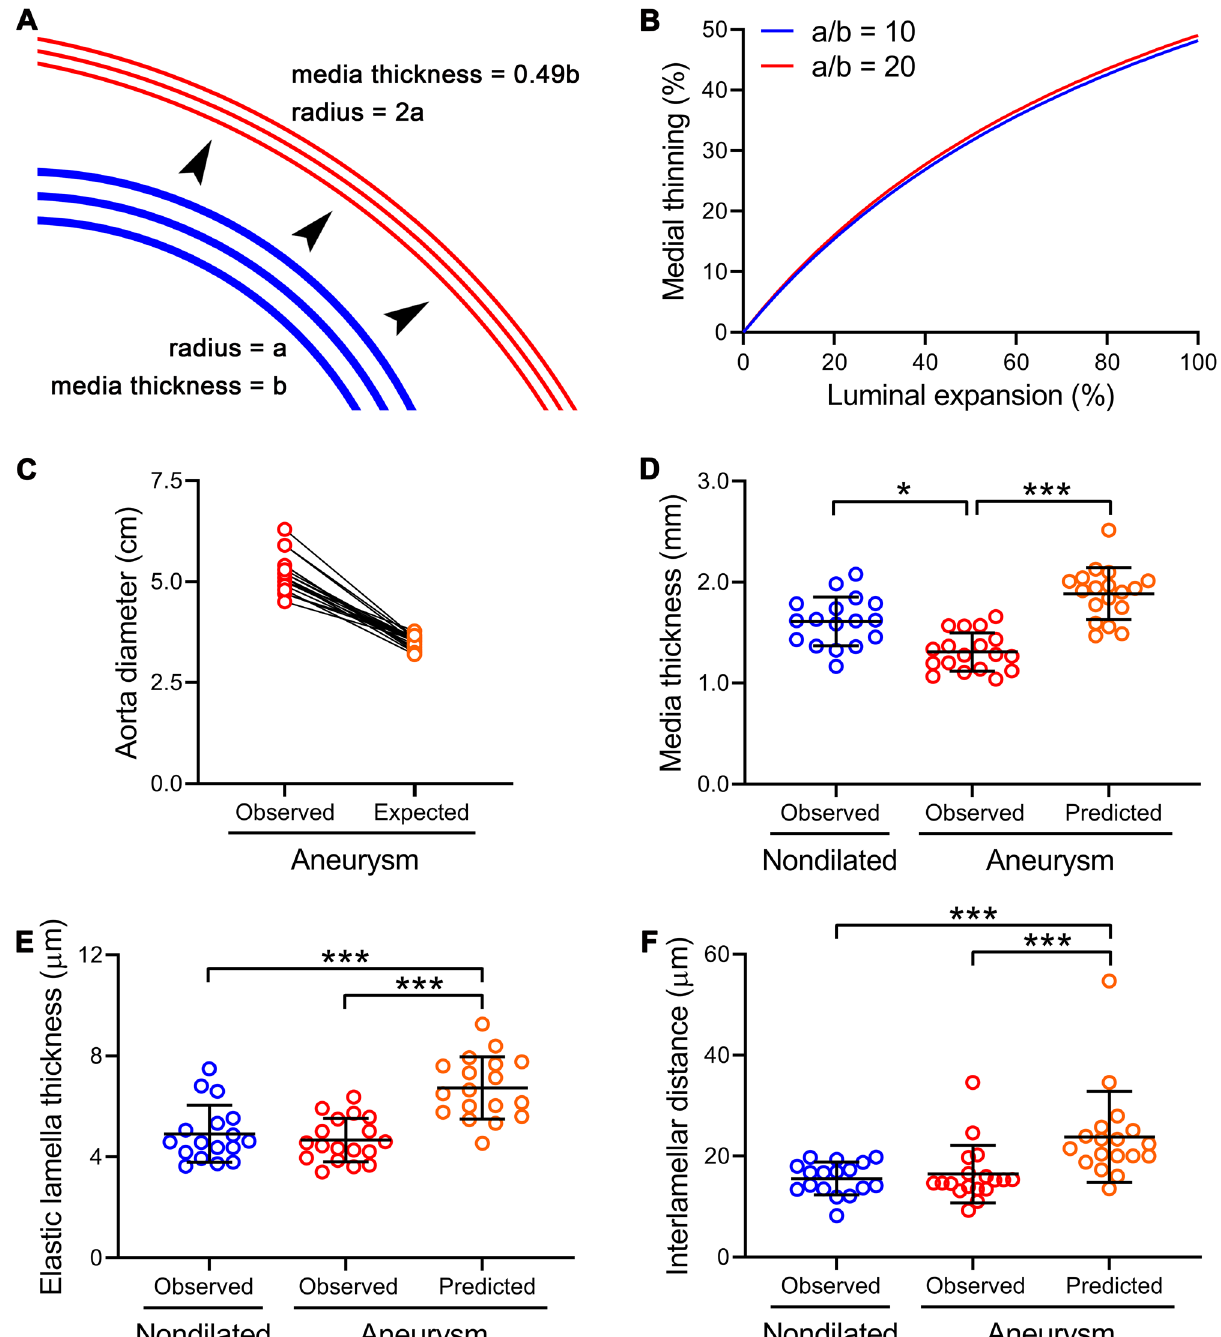
Figure 4. Gain of medial components in aortic aneurysms. ( A ) Enlargement of the lumen is associated with thinning of the media and its concentric lamellae assuming preservation of medial area and ( B ) this relationship is described graphically for radius (a) to medial thickness (b) indices of 10 (typical of nondilated aortas) and 20 (typical of aneurysmal aortas). The derived equation (“Supplementary Appendix”) was applied to quantitative histomorphometry data of ascending aorta specimens from organ donors and patients undergoing aneurysm repair. ( C ) Luminal enlargement was calculated from observed to expected aortic diameters of aneurysm patients according to published nomograms of healthy subjects. ( D ) Media thickness, ( E ) elastic lamella thickness, and ( F ) interlamellar distance of nondilated aortas and observed and predicted values for aneurysmal aortas. Individual data shown with bars representing mean ± SD, n = 17 nondilated and n = 18 aneurysms, * P < 0.05, *** P < 0.001 aneurysm versus nondilated, Kruskal–Wallis test with Dunn’s multiple comparisons